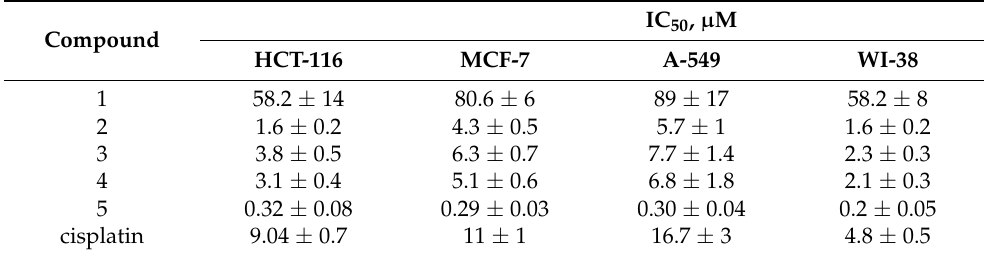
Table 6. IC 50 values ( µ M) against HCT-116, MCF-7, A-549 and WI-38 cell lines for compounds 1 – 5 and